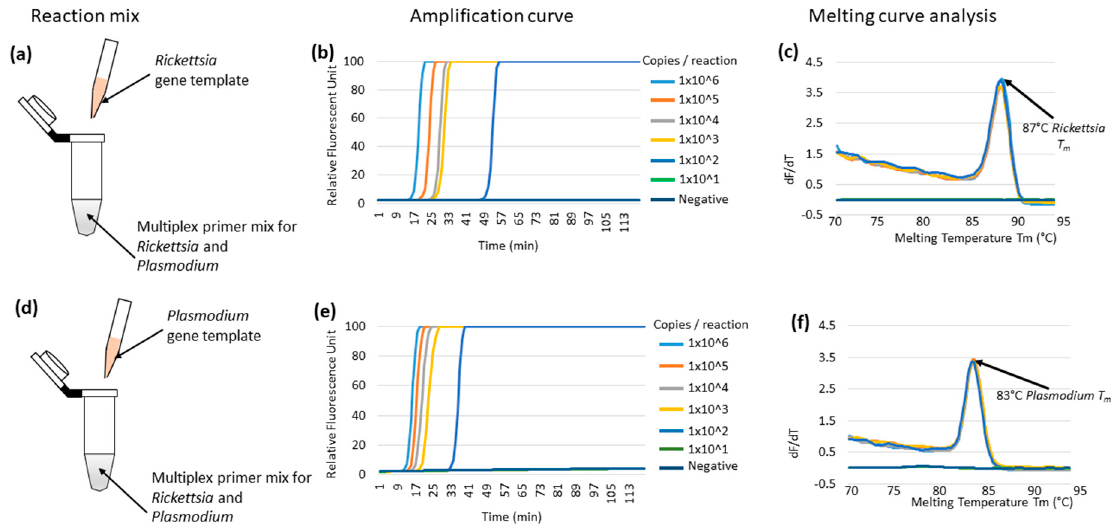
Figure 1. Multiplex LAMP amplification using a synthetic single target gene template. ( a ) shows the multiplex LAMP primer mix and Rickettsia gene template. The amplification curve in ( b ) shows the detection of up to 100 Rickettsia gene copies per reaction. The melting temperature for Rickettsia gene is shown to be 87 °C in ( c ). ( d ) shows the multiplex primer mix and the Plasmodium gene template for the reaction mix. The multiplex LAMP sensitivity shows the detection of up to 100 Plasmodium gene copies per reaction ( e ). The Plasmodium gene melting temperature shows 83 °C ( f ).